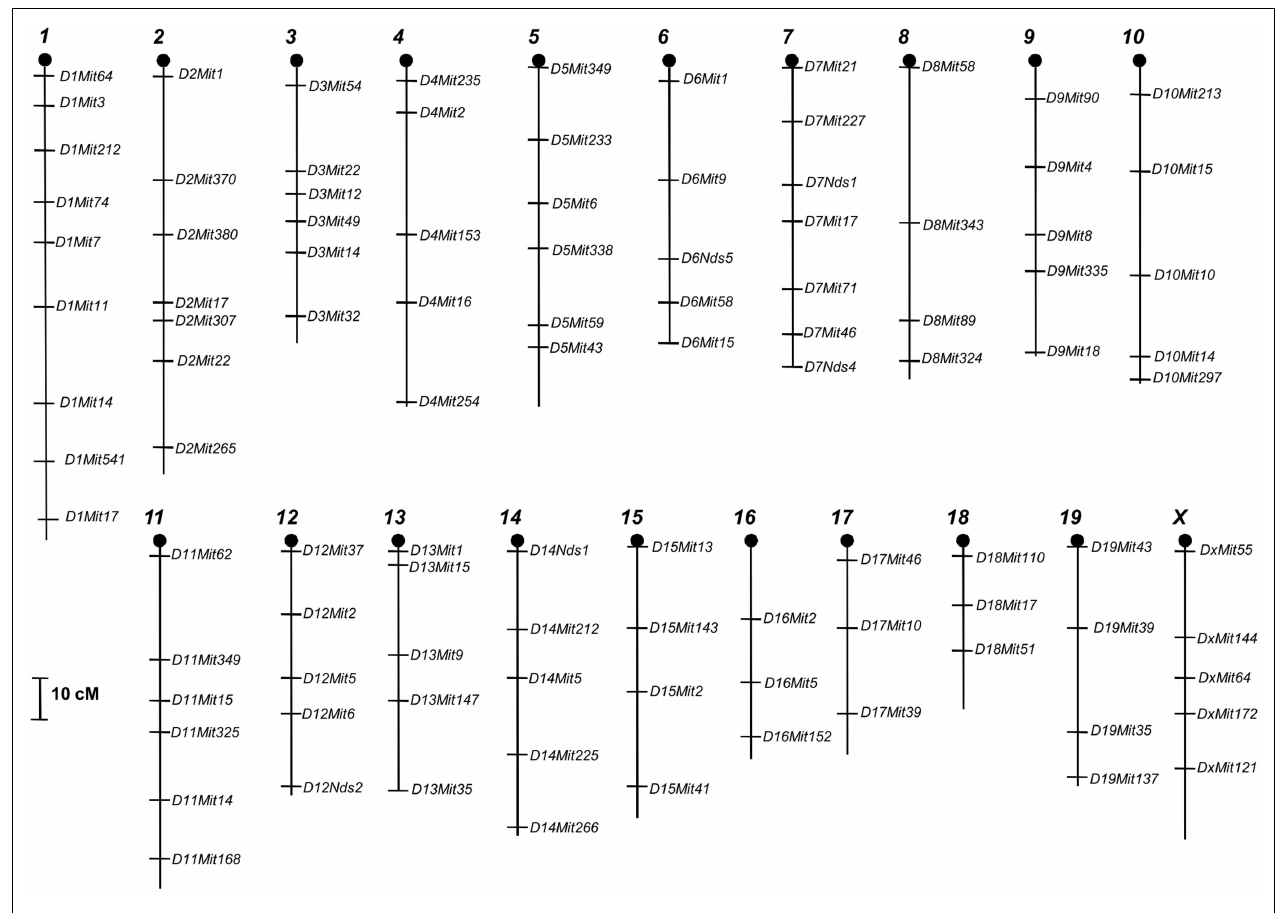
FIGURE 1 | Microsatellite marker’s location used in all 20 chromosomes of mice genome.